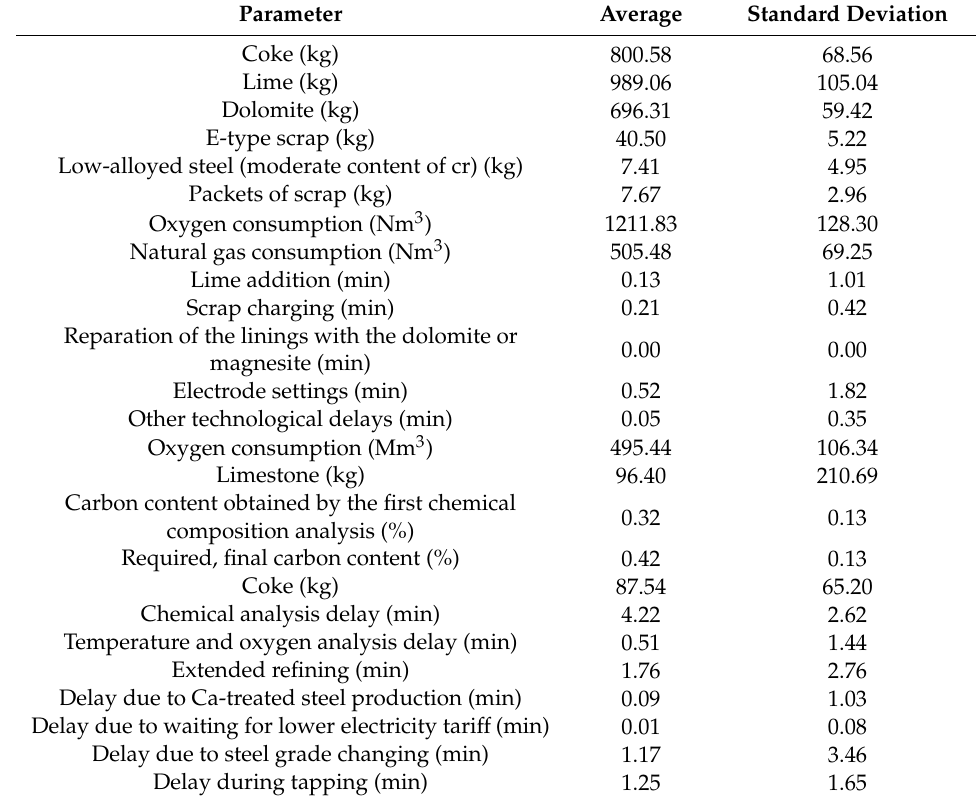
Table2. Theaveragevaluesandthestandarddeviationofindividualparametersfrom3248consecutively produced batches at the Štore Steel Ltd. in